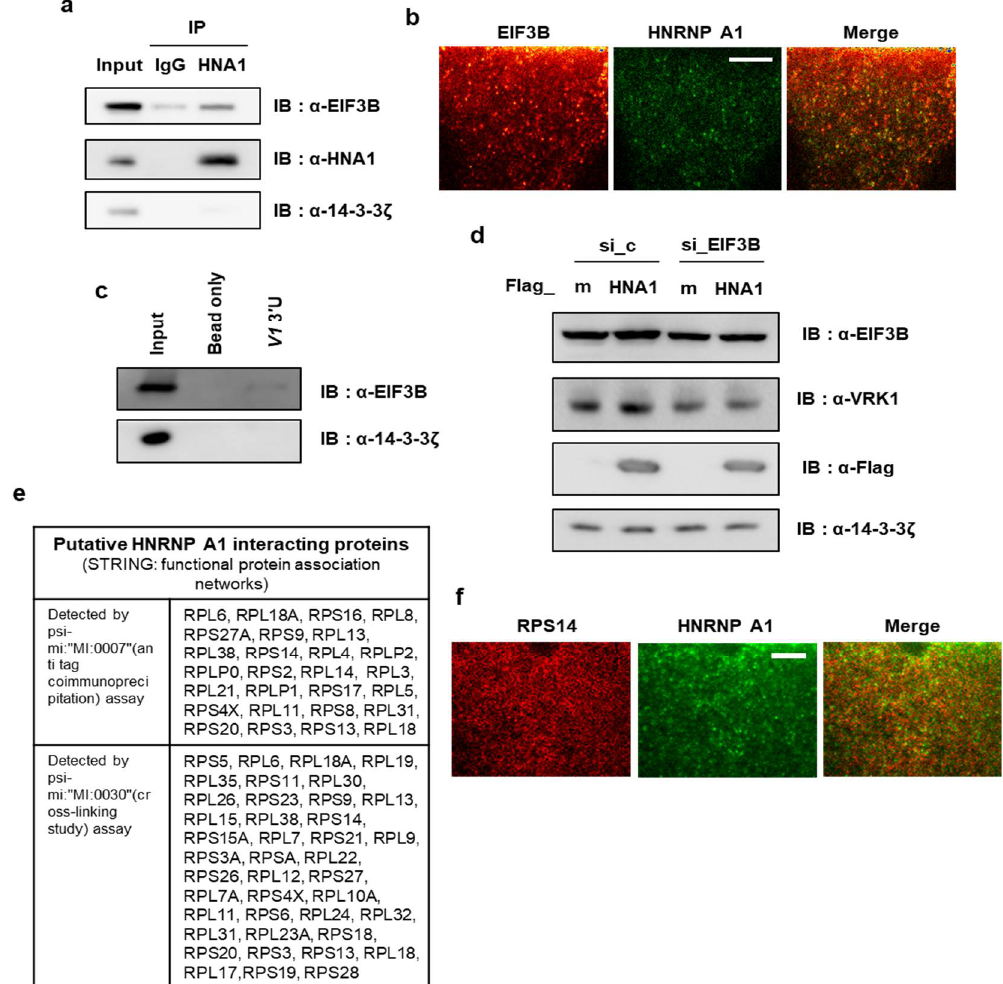
Figure 5. HNRNP A1 interacts with translation initiation factor EIF3B and ribosomal proteins. ( a ) HEK293A cells were subjected to immunoprecipitation with HNRNP A1. Immunoblotting was performed with specific antibodies. ( b ) The localization of HNRNP A1 and EIF3B was observed with a stimulated emission depletion (STED) fluorescence microscopy. Scale bar, 20 µ m. ( c ) Biotin-RNA pulldown indicated that EIF3B was capable of binding with the 3 (cid:48) UTR of VRK1 in HEK293A cells. ( d ) Either si_c or EIF3B targeting siRNAs (si_EIF3B) were transfected with either Flag_mock (F_m) or Flag_HNRNP A1 (F_HNA1) into HEK293A cells. After 36 h incubation, cells were subjected to immunoblotting with annotated antibodies. ( e ) The table for putative HNRNP A1 interacting proteins identified by in silico prediction is shown. ( f ) Immunostaining was performed with HNRNP A1- or RPS14-specific antibodies. RPS14 was visualized using Alexa 594-conjugated secondary antibody. For HNRNP A1, Alexa 647-conjugated secondary antibody was used for visualization with a STED microscopy. Scale bar, 20 µ